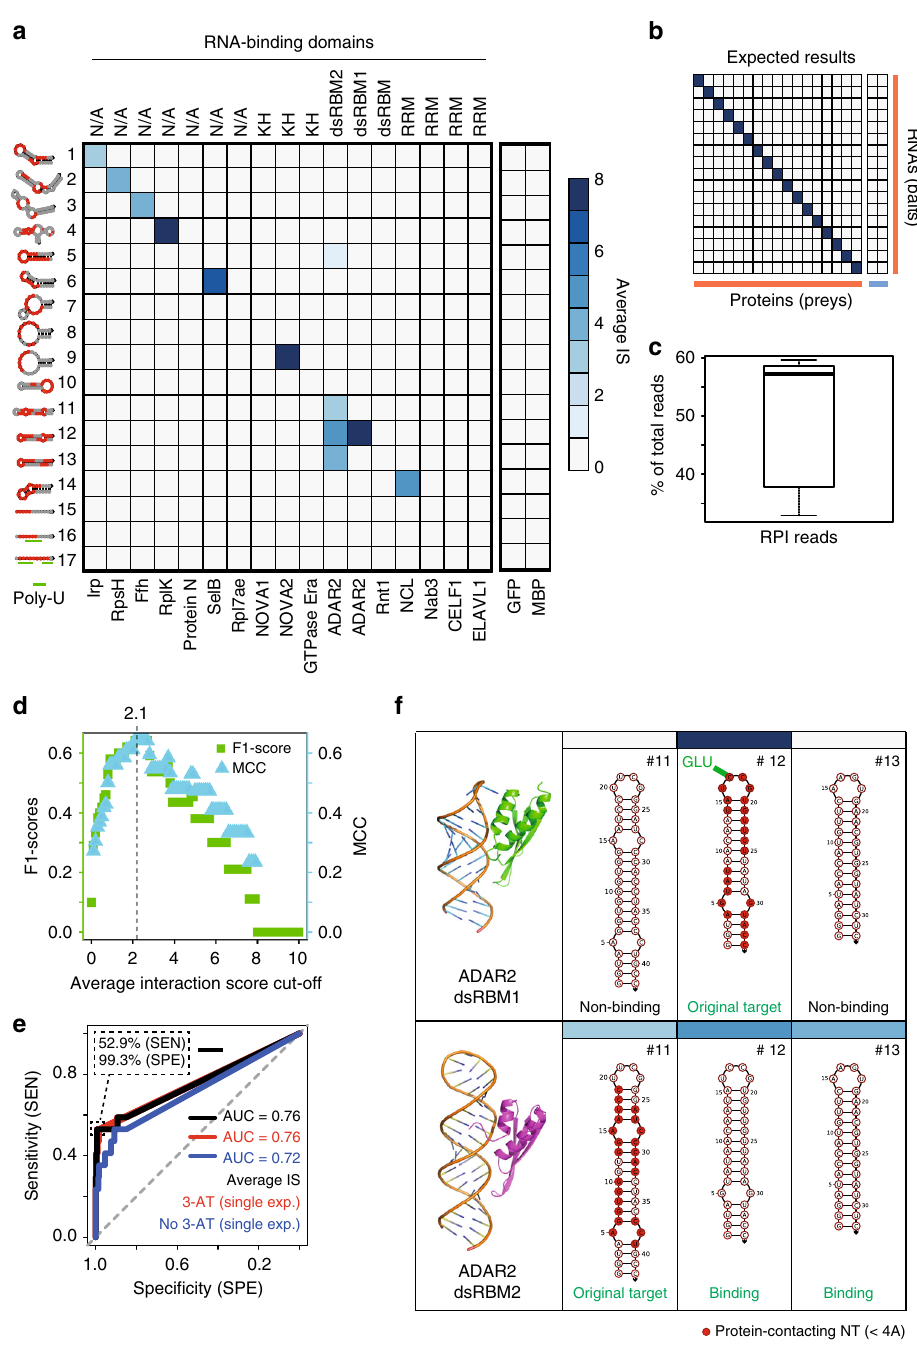
Fig. 6 Simultaneous multi-RNA – protein interaction mapping by rec-Y3H. a Interaction matrix showing the average IS between 17 RNAs and 19 proteins. The RNA – protein pairs were selected from published RNA – protein complex structures 33 . GFP and MBP are negative controls, while IRP-IRE (RNA #1) is a positive control (see Supplementary Data 7 for full list). On the left, secondary structures of the screened RNAs are represented. Red-coloured dots indicate protein-contacting nucleotides (<4 Å). Green lines represent Poly U sequences ≥ 4 consecutive Us, which cannot be detected by RNA polymerase III-based Y3H screens. RNA-binding protein names are represented along the bottom. RNA-binding domain class is speci fi ed at the top when applicable. b Expected RNA – protein interaction map 33 . c Estimation of rec-Y3H read mapping ef fi ciency. The box of the box plot illustrates the median, upper, and lower quartiles for read mapping ef fi ciencies. On average, 50.5% of reads are usable for mapping interaction pairs. d Optimal interaction score cut-off based on F1-Score (green) and Matthews ’ s Correlation Coef fi cient (MCC, cyan). e Overall performance (AUC) of rec-Y3H based on the expected 17 diagonal positive and 306 off-diagonal negative interaction pairs. The black, red, and blue lines indicate the averaged and individual (with and without 3AT) experiments, respectively. The grey-dotted diagonal line shows random performance. The inset shows assay sensitivity and precision at an optimal cut-off of 2.1, as de fi ned based on the F1-Score in the preceding panel. f NMR structures of two dsRBMs that show distinct behaviour in rec-Y3H. dsRBM1 binds close to the apical loop, contacting speci fi c unpaired bases present only in the loop of RNA #12, while dsRBM2 less speci fi cally binds along the double- stranded